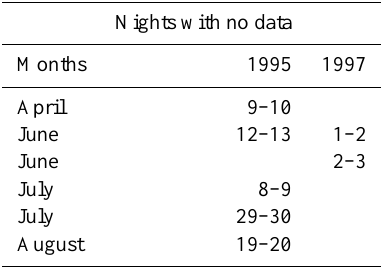
Table 1. Nights with no data in 1995 and 1997 Nights with no